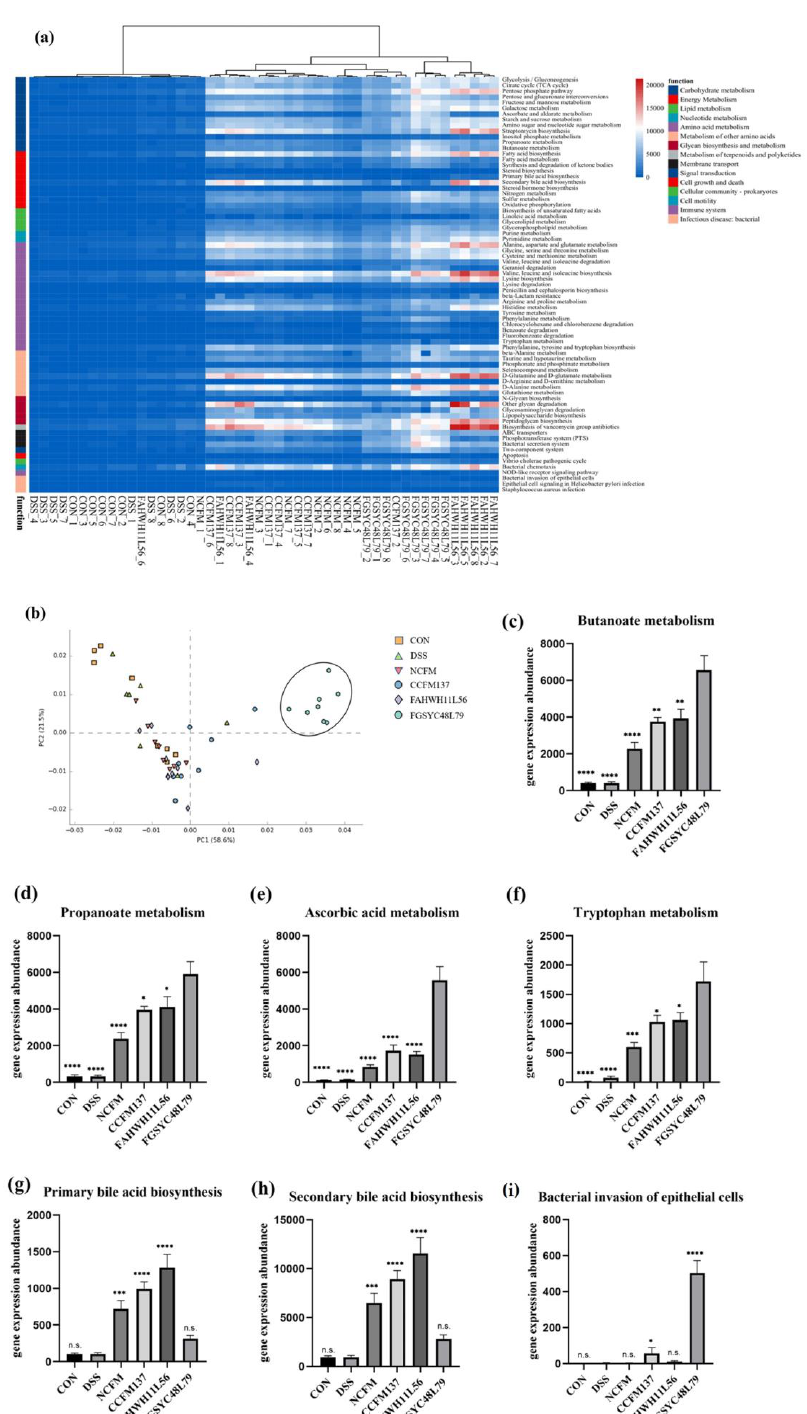
Figure 7. PICRUSt analysis on gut microbiota after L. acidophilus intervention. ( a ) Heatmap of prediction on gut microbiota function, ( b ) PCA analysis of prediction on gut microbiota func- tion, ( c – i ) predictive gene expression abundance of gut microbiota on butyrate metabolism, propi- onate metabolism, ascorbate metabolism, tryptophan metabolism, primary bile acid synthesis, and secondary bile acid synthesis of gut microbiota, and ability of bacteria to invade epithelial cells. *: p < 0.05. **: p < 0.01. ***: p < 0.001. ****: p < 0.0001. N.s.: no significant difference. All data are presented as mean ± standard error of the mean (SEM). In figure c – f , the FGSYC48L79 group was used as a reference. In figure g – i , the DSS group was used as a